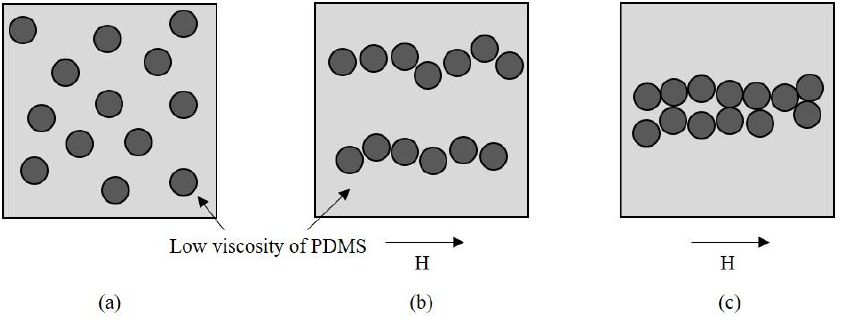
Figure 4. Illustration of particle alignment process in the pre-polymer state: ( a ) Without magnetic field; ( b ) Magnetic field with short magnetization time; and ( c ) Magnetic field with long magnetization time.